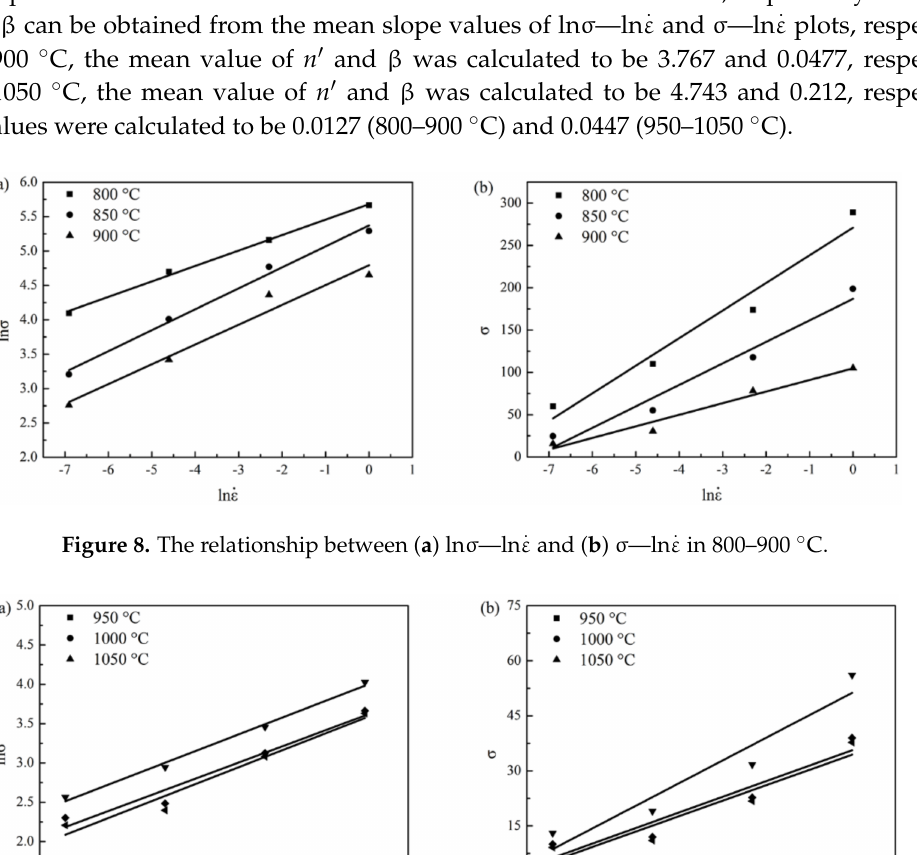
Figure 9. The relationship between ( a ) ln σ —ln